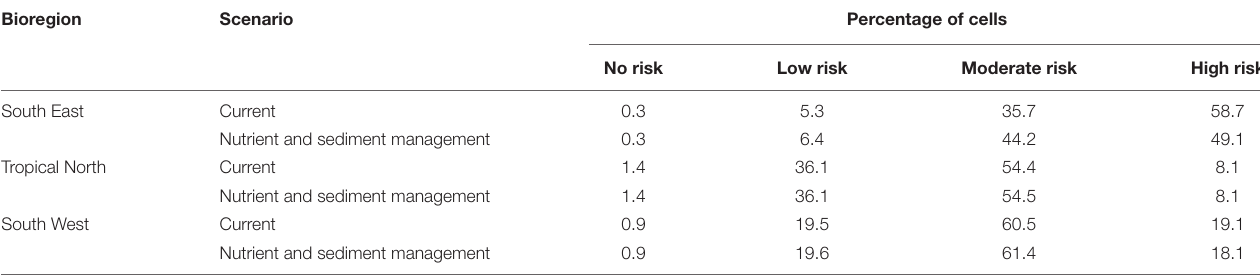
TABLE 3 | Comparison of how the percentage of cells under the different current cumulative risk categories changes following a simulated nutrient reduction.